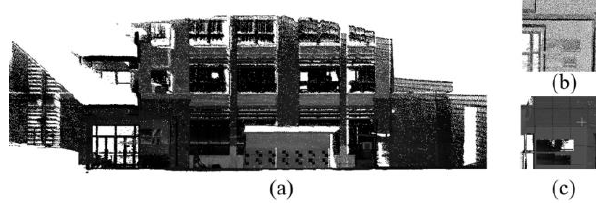
Figure 2. (a) Point cloud data acquired by our system. (b)